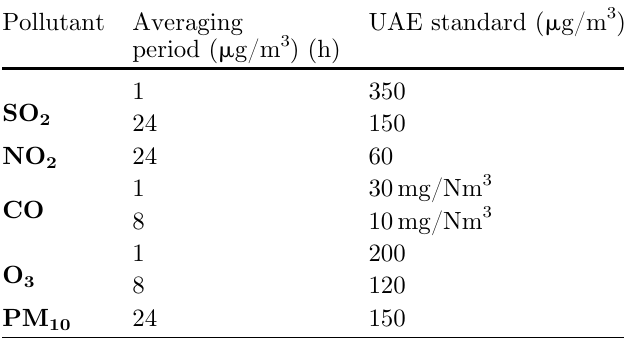
Table 1. Ambient air quality standard UAE